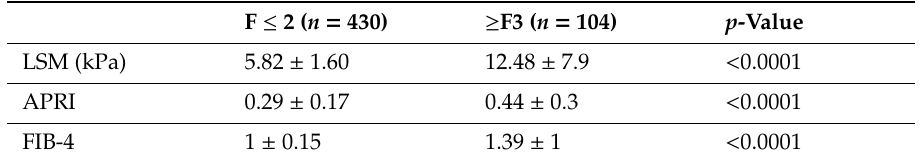
Table 7. Di ff erences between liver sti ff ness measurements (LSM), APRI, and FIB-4 scores among patients with mild and significant fibrosis (F ≤ 2) and those with advanced fibrosis ( ≥